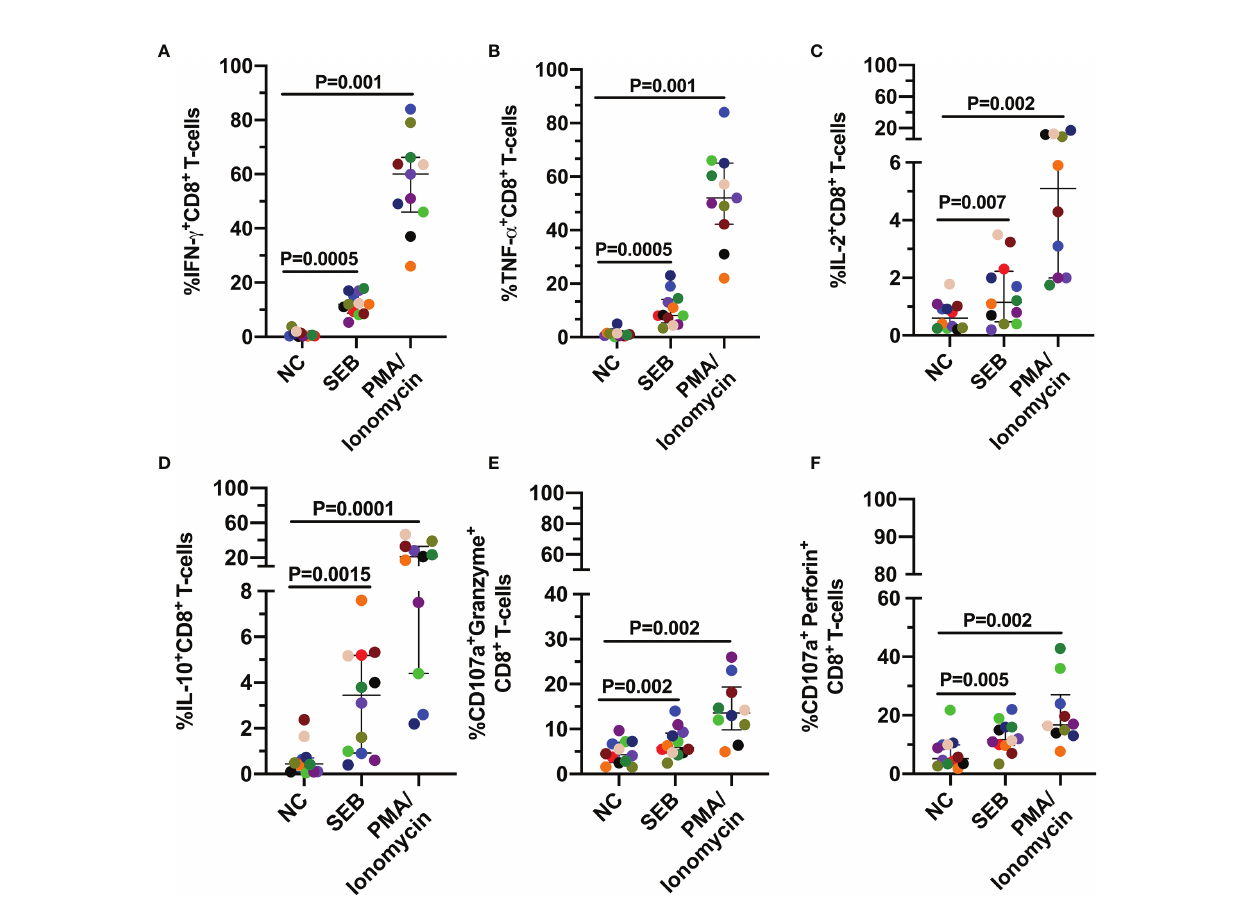
FIGURE 1 | CD8 + T-cell response to polyclonal antigen-independent stimulation. Frequencies of CD8 + T-cells positive for IFN- g (A) , TNF- a (B) , IL-2 (C) , IL-10 (D) , and CD107a together with granzyme B (E) or perforin (F) . Each point represents the CD8 + T-cell response in the negative control (NC), and after stimulation with SEB and PMA/Ionomycin (PMA) for 12 hours. The Wilcoxon test was used to compare the response of cells stimulated with each polyclonal stimulus and NC. Plots depict median and IQR, n =